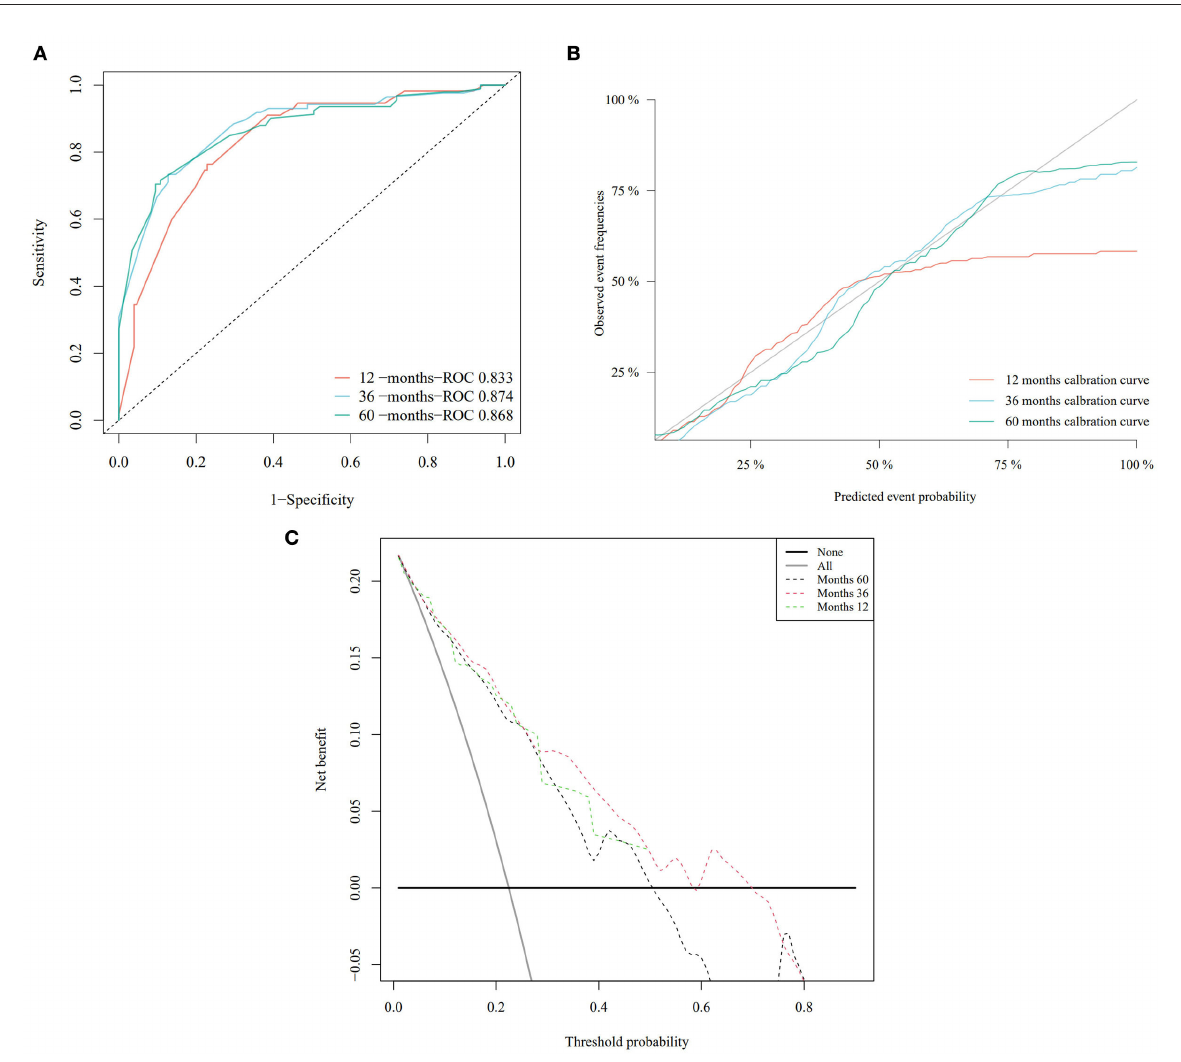
FIGURE5 The performance of the nomogram model was evaluated with the validation set. (A) Receiver operating characteristic curve; (B) calibration curves; and (C) decision curve